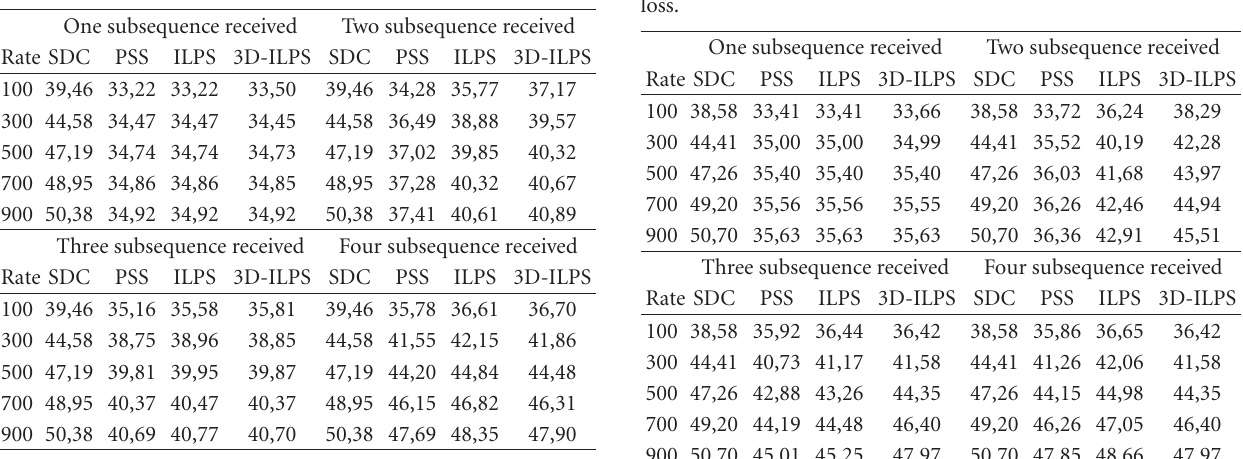
Table 1: Performance of depth view, Ballet, without packet loss.